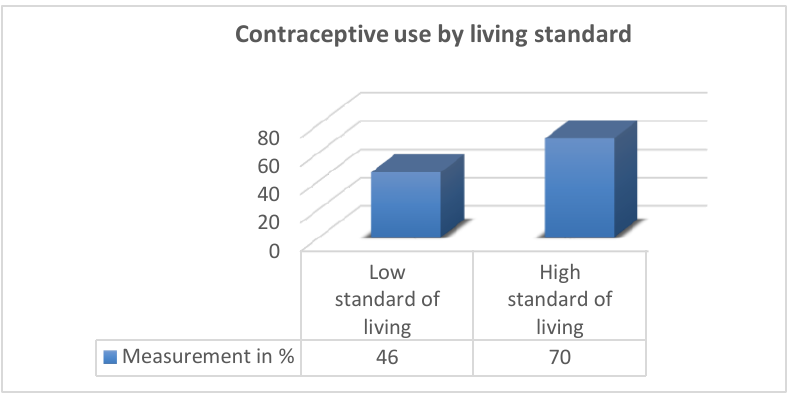
Figure 1: Use of modern contraceptive methods by the standard of living for women.